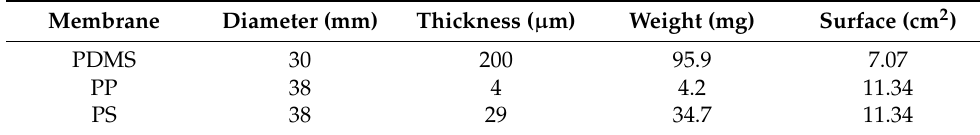
Table 2. Commercial membranes and their corresponding main